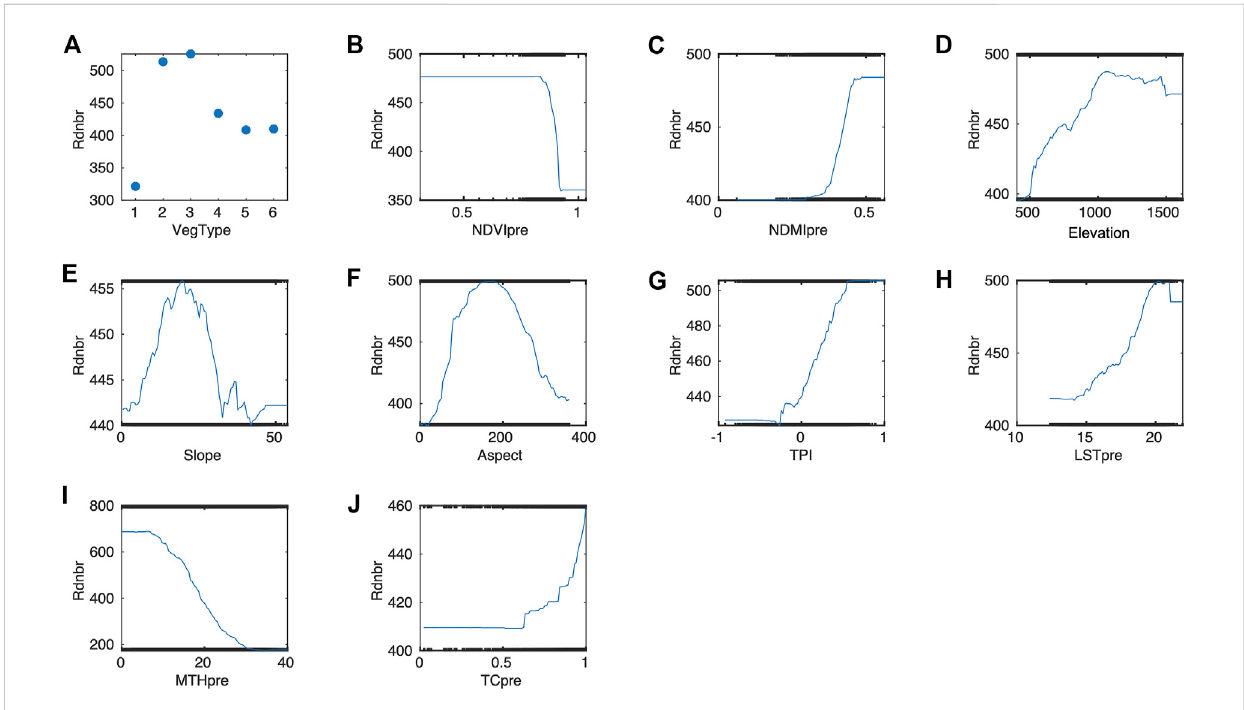
FIGURE 4 Partial dependence plots of explanatory variables ( n = 10) on regulating RdNBR of the CT2 fi re in Great Smoky Mountains National Park: (A) Vegetationtype, (B) NDVI